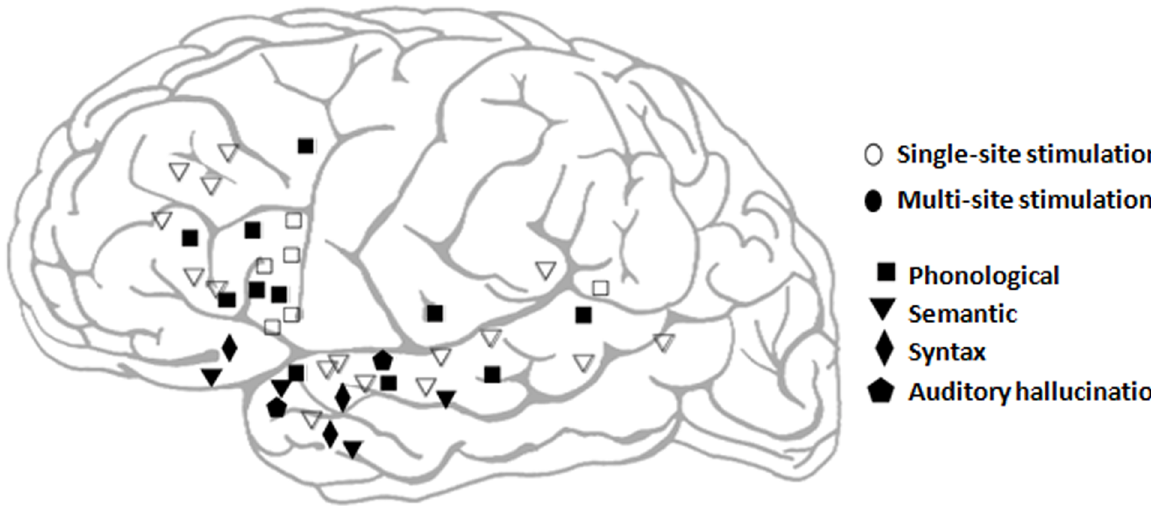
Fig 2. Schematic localization and classification of functional effects. The locations of stimulationsites (both single and multi) causingfunctionaleffects is plotted on a scheme of the left hemisphere for 7 of the 11 patients with multi-site effects (for the remaining four patients: 1,4,11 and 12, intra-operative imagingwas not sufficient to map stimulationlocations). Singlesites (SSS) are marked with unfilledshapes, multi-site (MSS) are marked with filled shapes. Language disturbancesare classifiedto phonological (square), semantic (triangle), syntactic (diamond) and auditory hallucinations